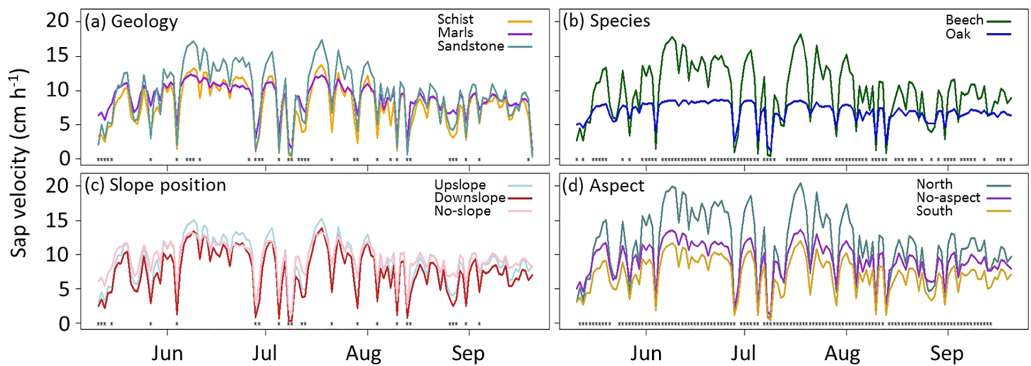
Figure 5. Differences between sap velocities depending on (a) geology, (b) species, (c) slope position and (d) aspect. Lines show the average dynamics of each class. Asterisks at the bottom of the panels indicate significant differences for that day according to Mann–Whitney U or Kruskal–Wallis tests at α = 0.05, for differences between the two or three categories,